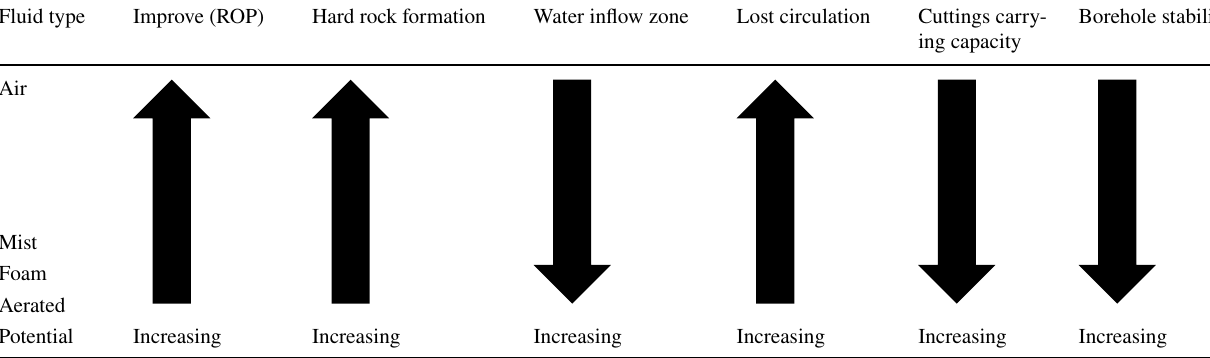
Table 5 Summary of UBD fluid system applications Fluid